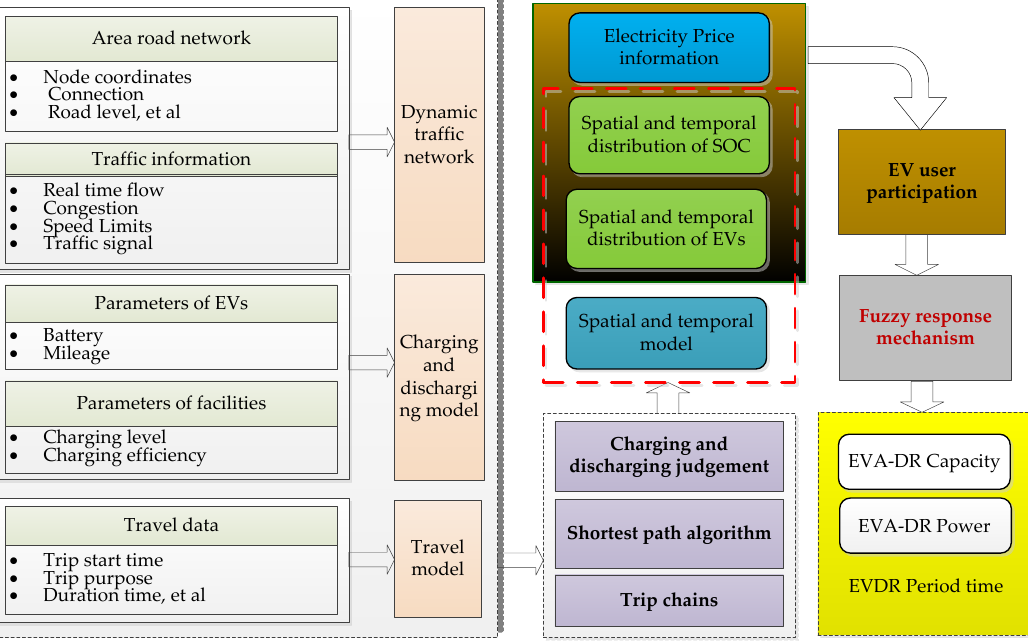
Figure 1. Scheme of proposed EVA-DRE method.